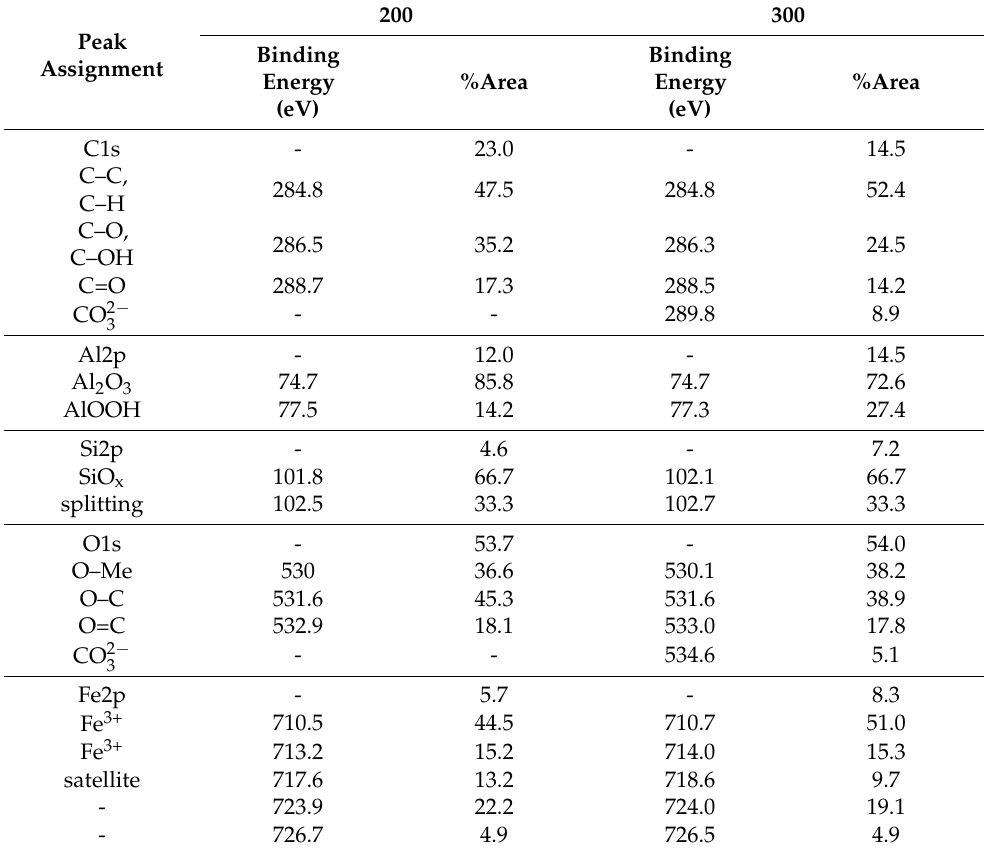
Table 9. XPS analysis of sample surfaces after 24 h of